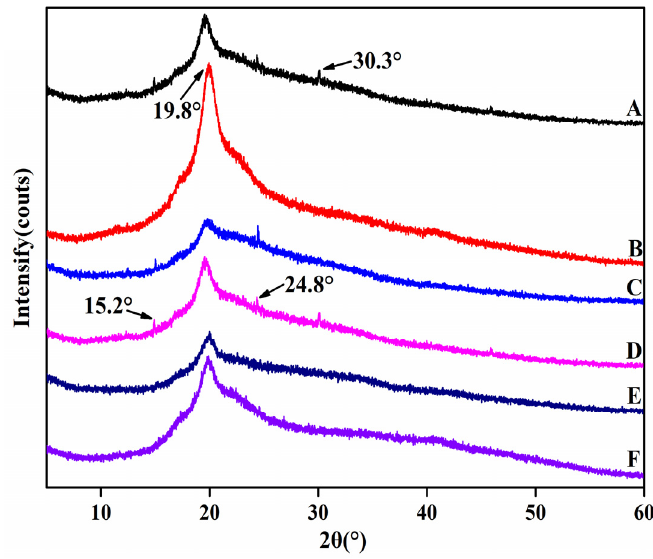
Figure 6. XRD patterns of composite membrane samples (A) starch–PVA; (B) HNTs/starch–PVA;